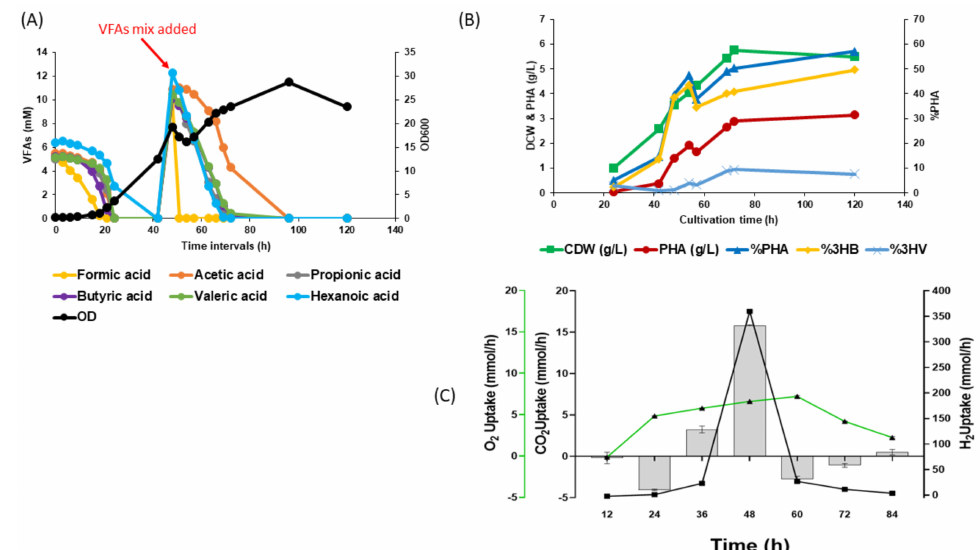
Figure 3. C. necator H16 two-step mixotrophic fermentation in a bioreactor. Panel ( A ) growth (black line, OD600) and VFAs utilisation profile (colored lines corresponding to individual VFAs) under two step feeding regime.; Panel ( B ) cell dry weight (CDW) and PHA production profile under two step feeding regime. Biomass, wt% of PHA and PHA titer was monitored from 24 to 120 h of cultivation; Panel ( C ) gas utilisation profile under two step feeding regime. CO 2 and H 2 gas consumption were calculated as average of various time intervals. Legend: CO 2 uptake—grey bars, H 2 uptake—black line and O 2 uptake—green